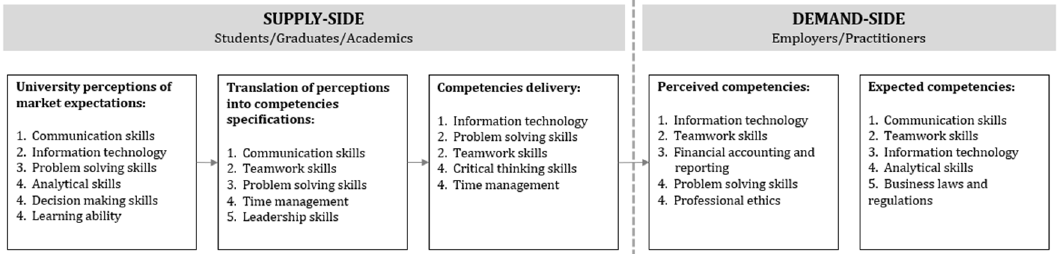
Figure 3. Ranking of the most relevant competencies using Kroon and Alves’s (2022) framework. Based on the expected competencies, we conclude that there is some misalignment between supply and demand. Although the supply side perceives the most expected competency (communication skills) as such, it is not part of the most delivered and perceived competencies. This indicates that the development of this competency within the university is not being accomplished as intended, despite the awareness of its importance. Something similar happens with the competency that appears in the fourth place of the most expected competencies: analytical skills. This competency was not delivered or perceived at all, indicating an even bigger failure of the university.